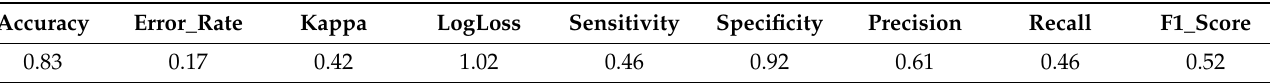
Table 6. Metrics evaluated for Decision